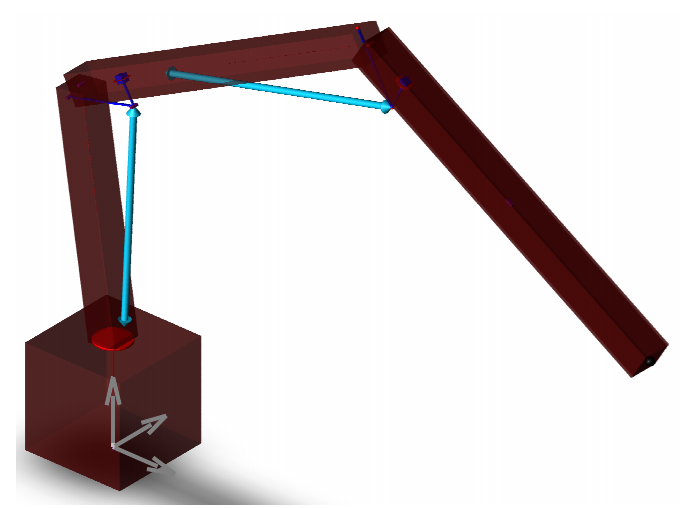
Figure 5. 3D view of the crane in SimulationX.